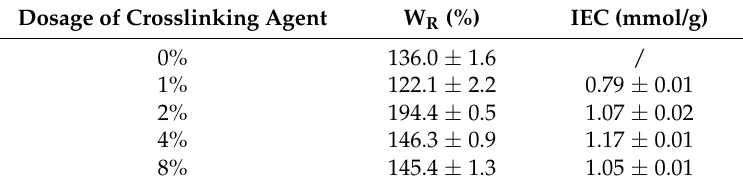
Table 1. Water uptake (W R ) and ion exchange capacity of membranes (after 100 ◦ C treatment).